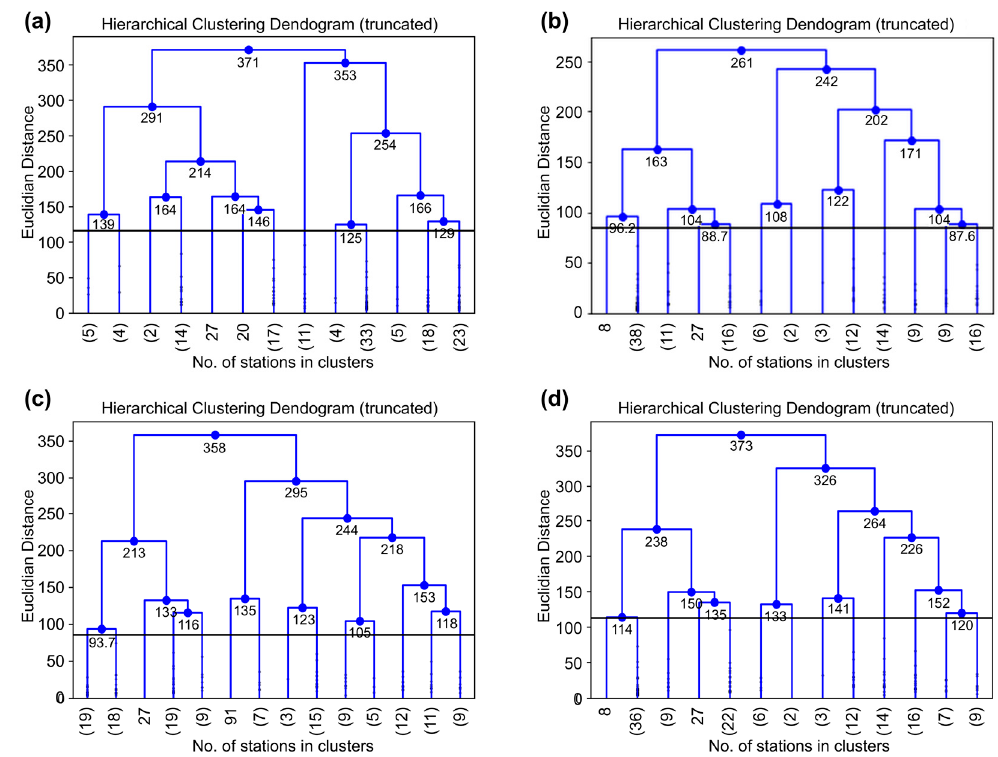
Figure 7. Dendrograms with cut-off bars to group the stations in clusters as a function of the Euclidean